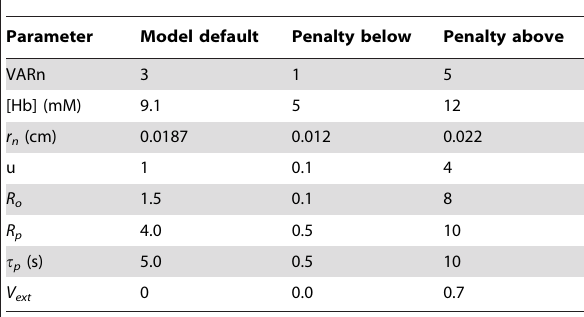
represent a worsening of the prediction following optimisation compared to predictions of the default model. This latter